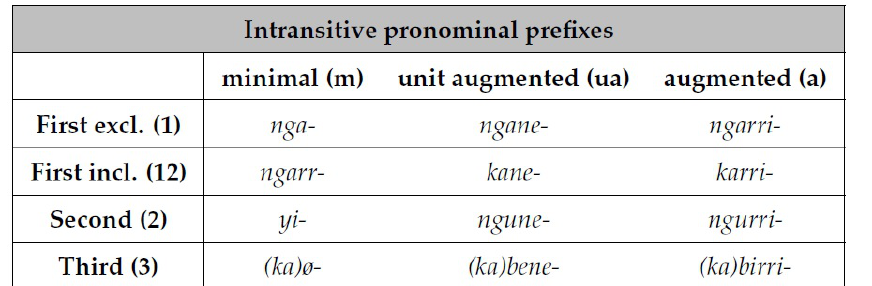
gaps in the matrix cells as a result of undefined person number